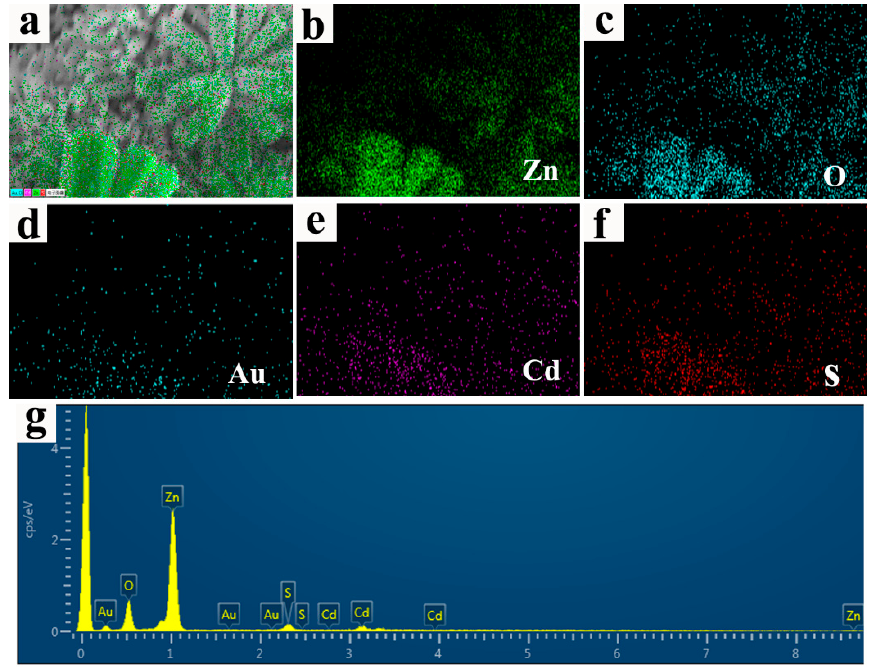
Figure 3. ( a – f ) EDS mapping images of the ZnO/Au/CdS sample; and ( g ) EDS image of the ZnO/Au/CdS sample.